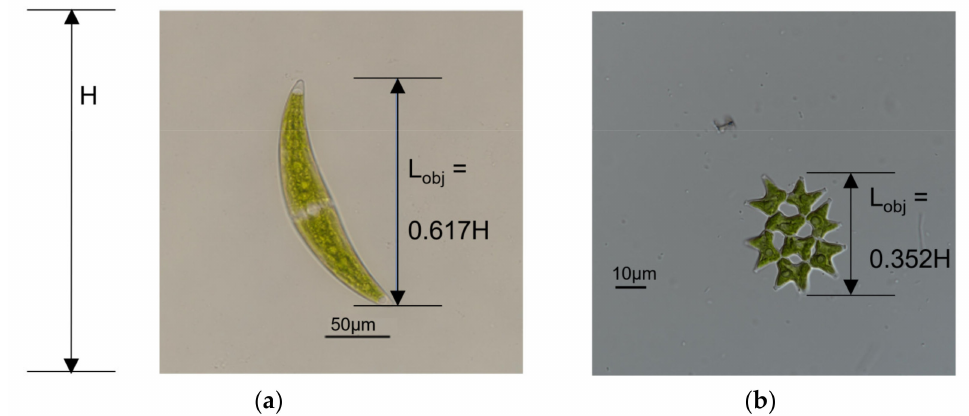
Figure 8. The original images used to test the effect of relative object size on model performance. ( a ) Closterium sp. ( b ) Pseudopediastrum boryanum